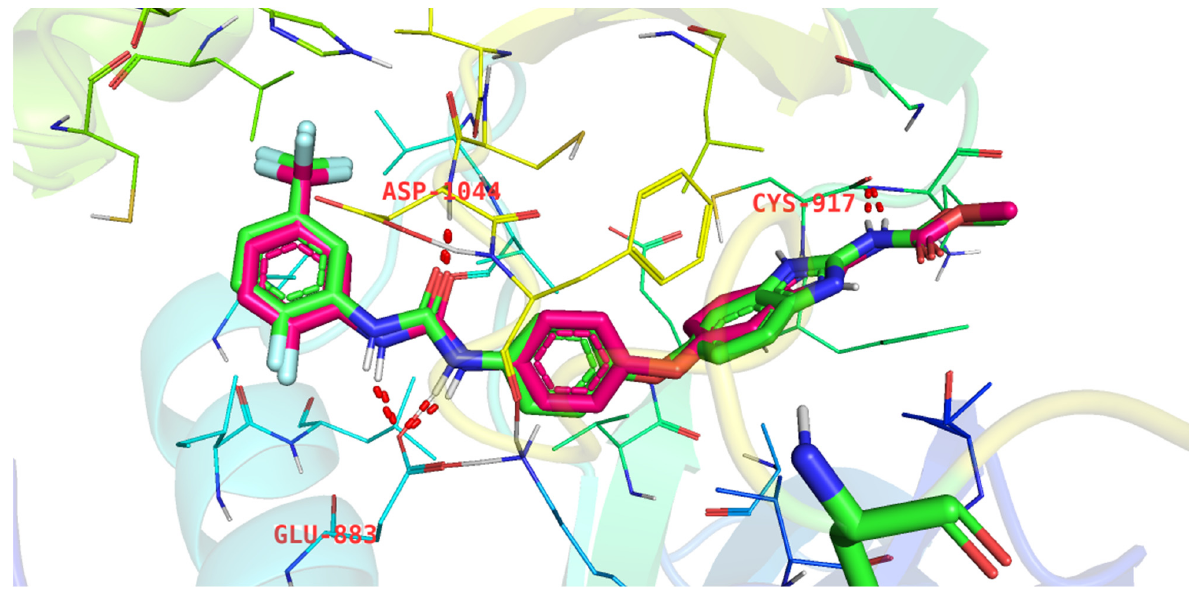
Figure 5. Superimposition pose of the native ligand (pink) and the re ‐ docked one (green). The RMSD between these ligands equals 0.98 Å.